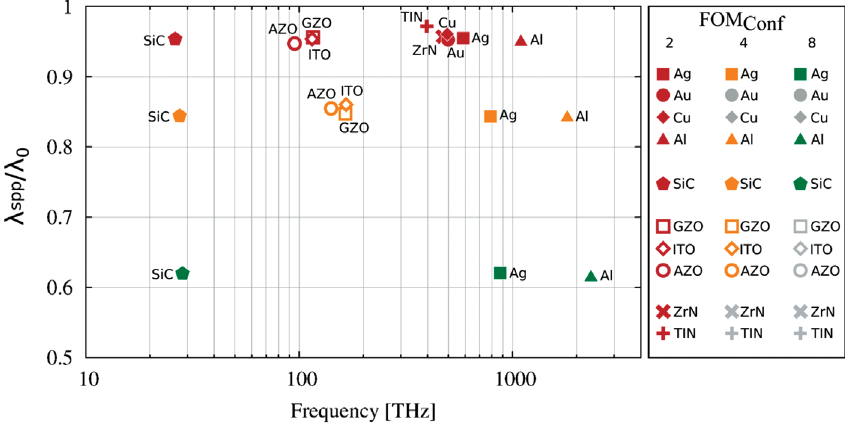
) over the free-space wavelength ( λ spp